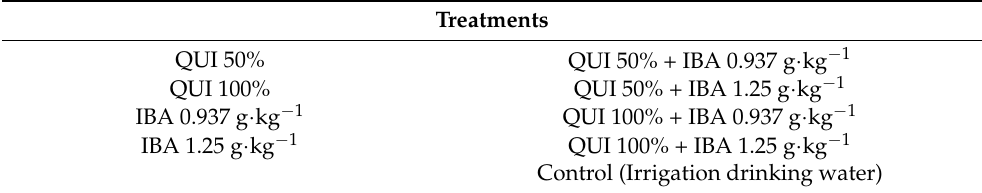
Table 1. Treatments based on Chitosan bioproduct of marine origin (QUI) and indole butyric acid (IBA) in conditions of the Altar desert, Sonora.